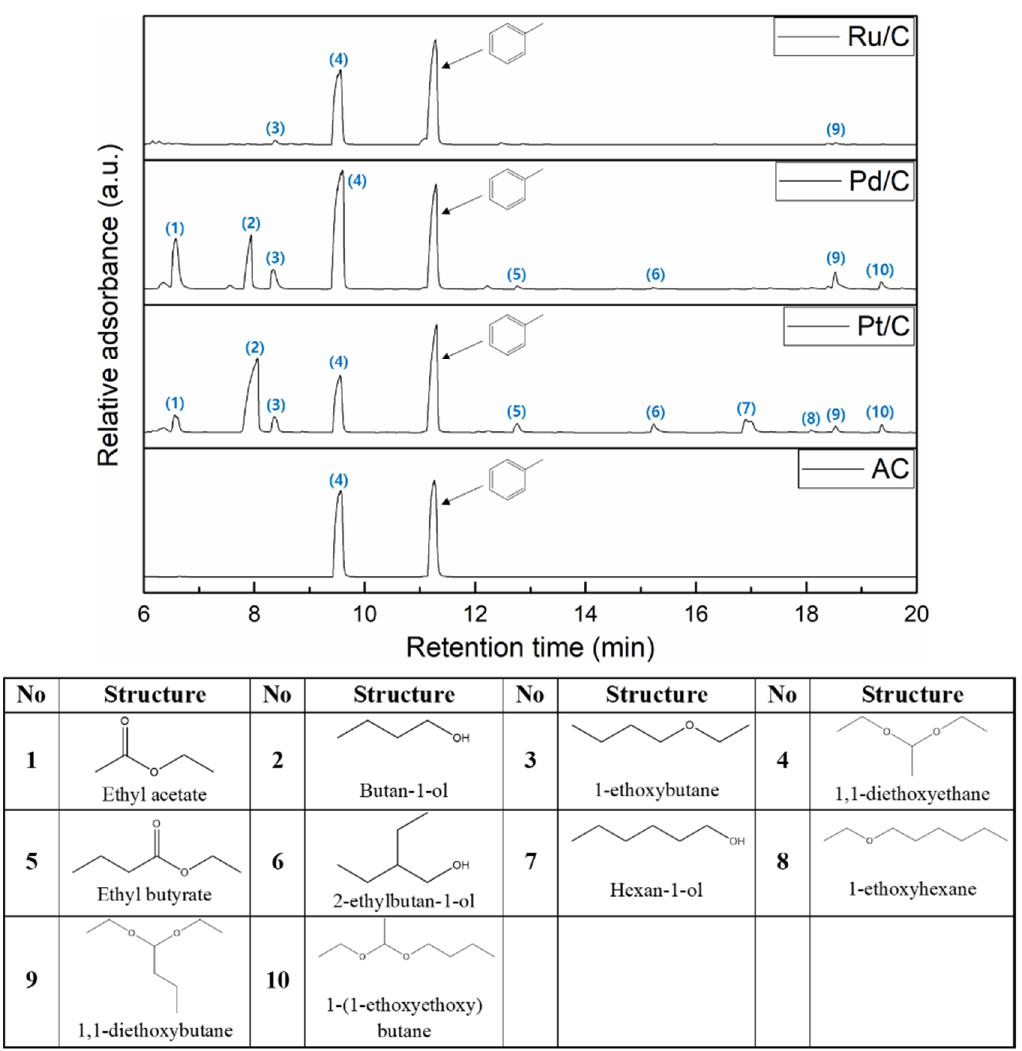
Figure 6. The GC-MS chromatograms of aliphatic compounds produced from BPE decomposition over the catalysts at 270 °C for 4 h in supercritical ethanol.